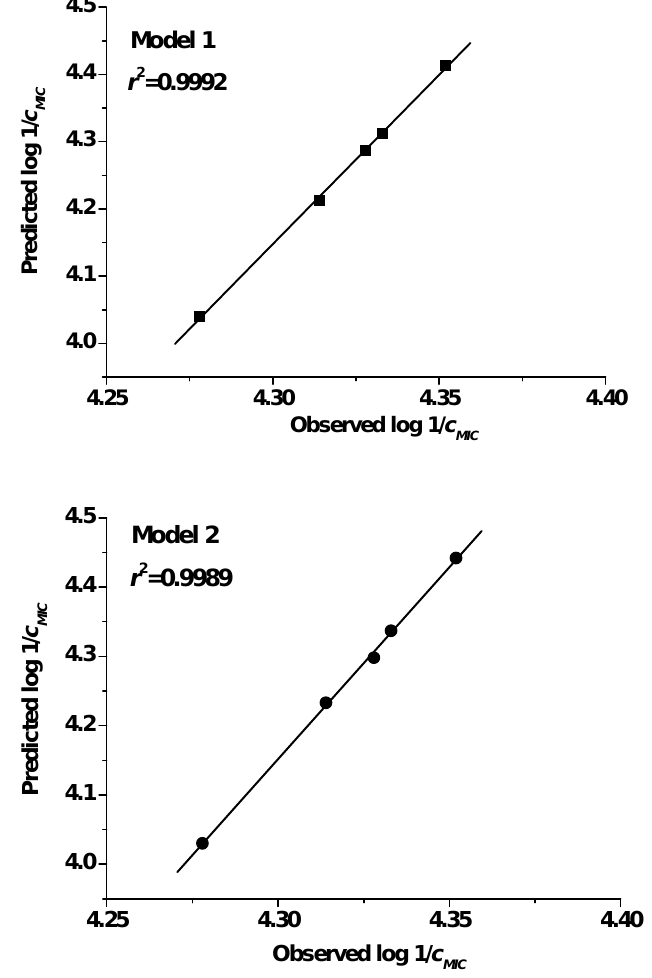
Figure 1. Plots of predicted versus experimentally observed inhibitory activity of benzimidazoles against Pseudomonas